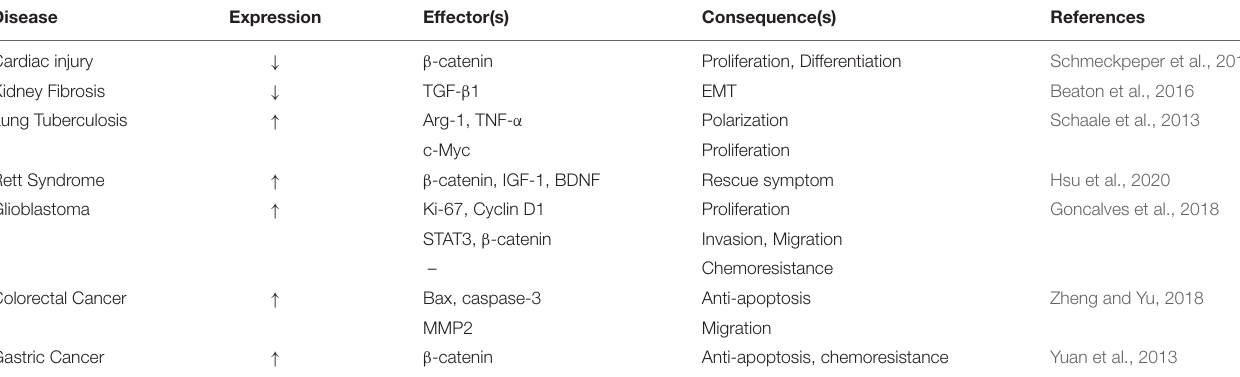
TABLE 1 | Summary of the expression and function of WNT6 in different